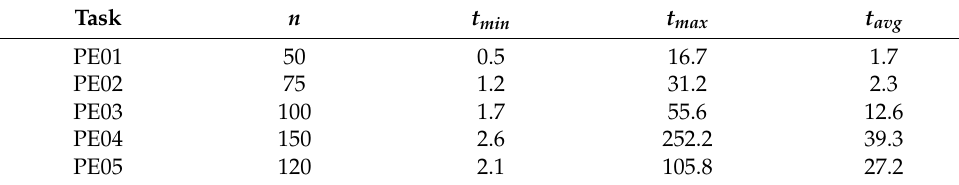
Table 6. Values of performance indicators for the search for optimal solutions. Task n t min t max t avg PE01